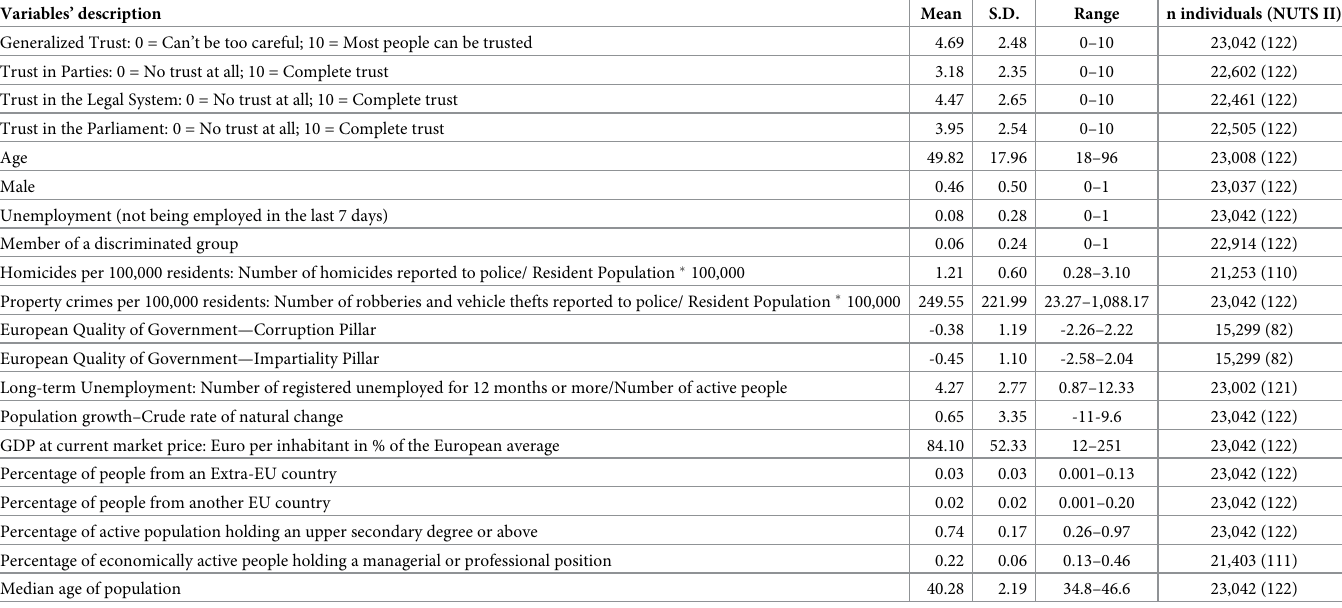
Table 2. Demographics and operationalization of main